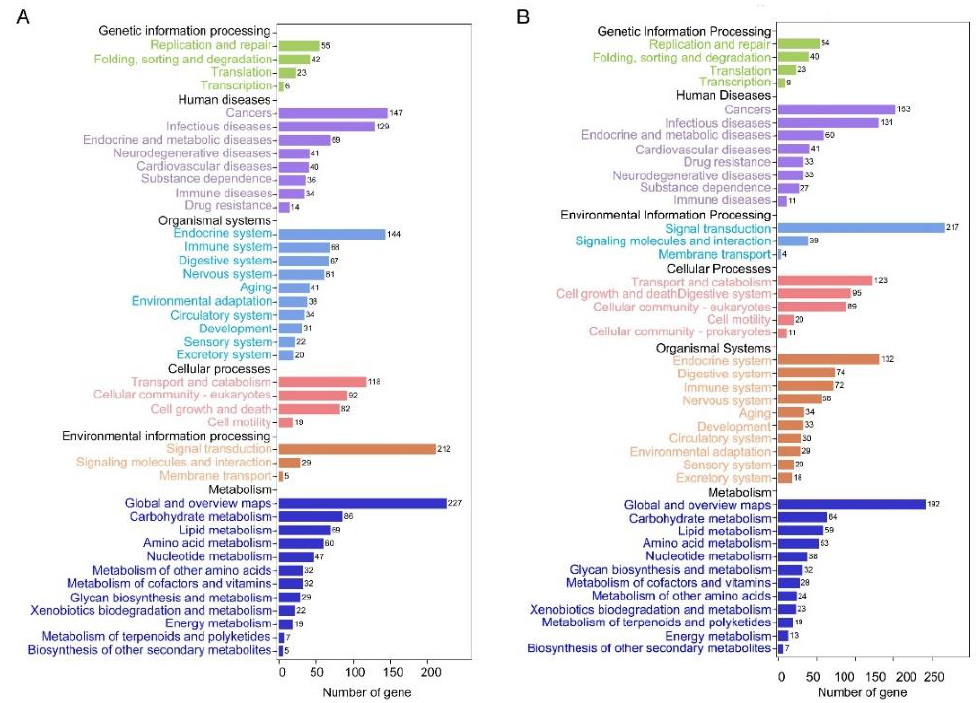
Figure 6. KEGG pathway classification of DEGs in the forewing ( A ) and hindwing ( B ) buds of 36 hAE-5th-star nymphs with NlFoxO and Gfp knockdown.